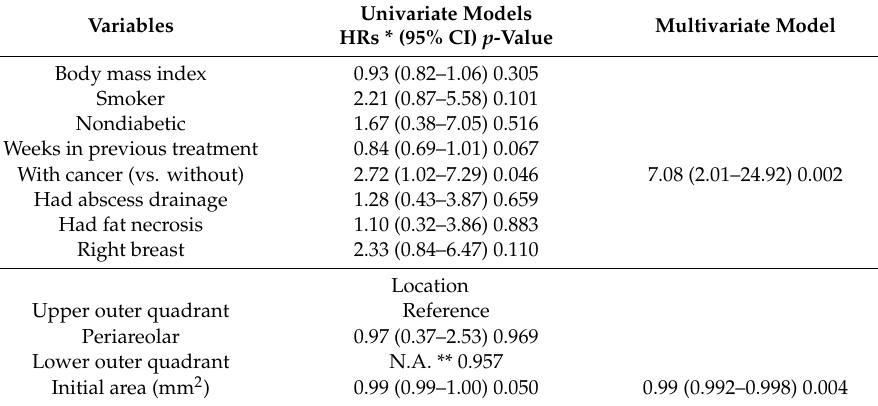
Table 2. Predictors of time of wound closure in Cox’s proportional hazards